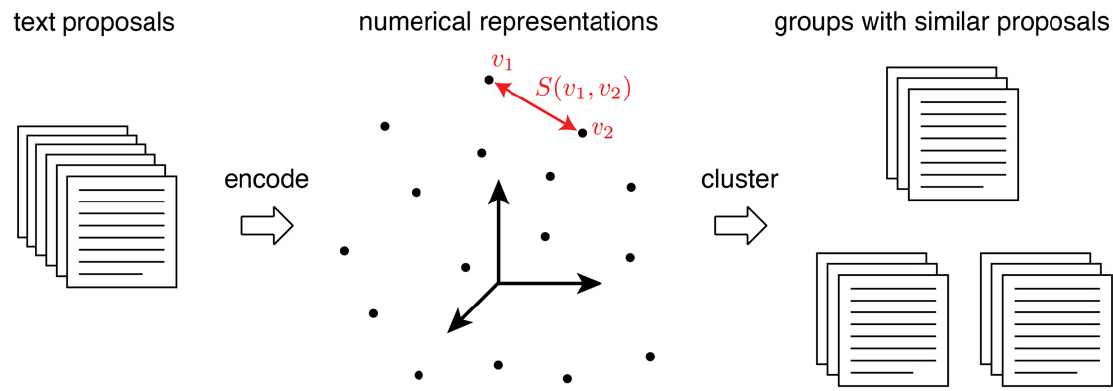
Figure 2. Schematic of the proposed method.